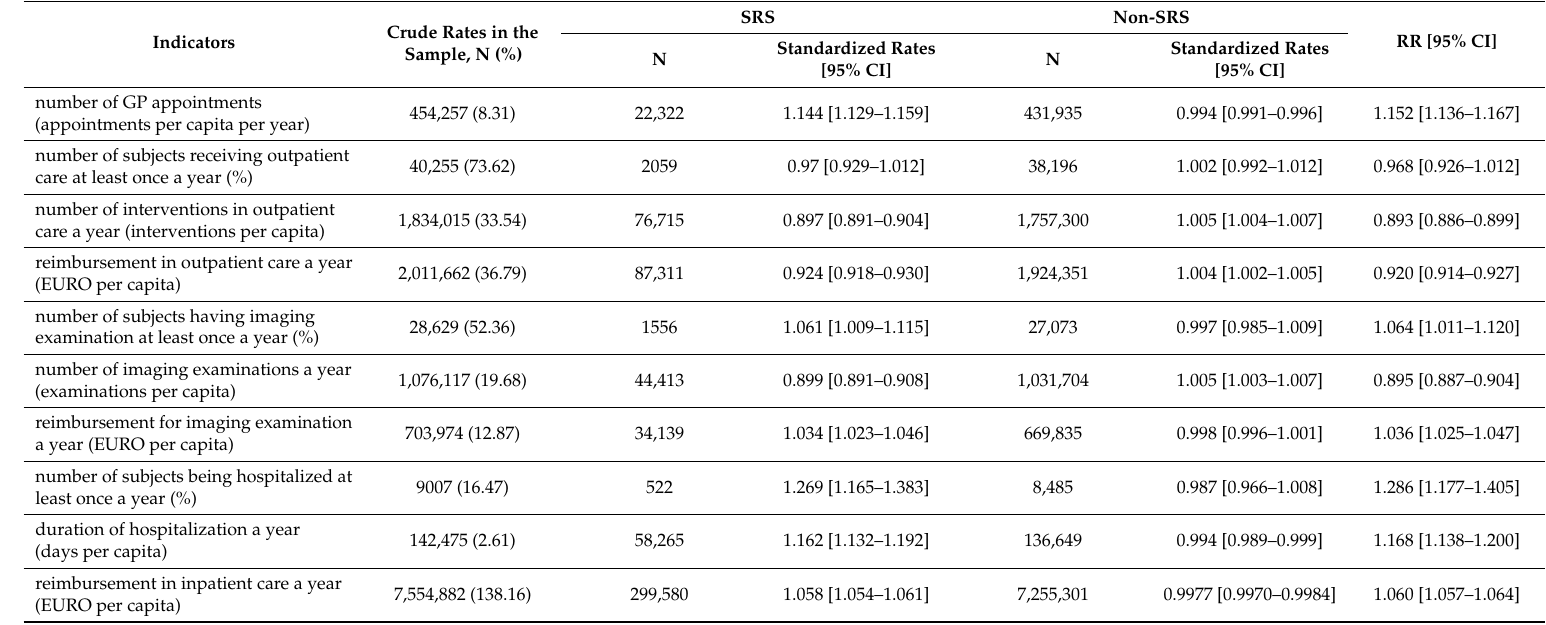
Table 2. Service delivery rates as pathway indicators for adults living in segregated Roma settlements (SRSs) and living in the same municipalities’ complementary areas (non-SRSs) with the age- and sex-standardized relative service delivery rates (RRs) for inhabitants of